Question: Summarize what this figure shows in one sentence.
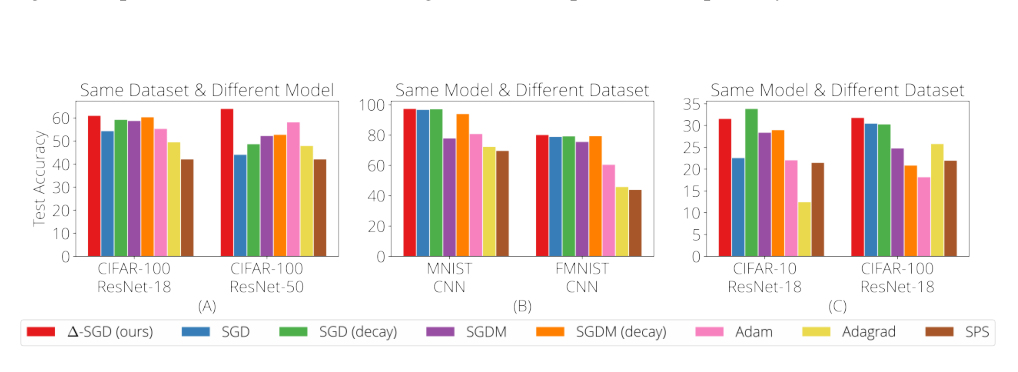
Answer: The effect of changing the dataset and the model architecture on different client optimizers. ∆-SGD remains superior performance without additional tuning when model or dataset changes, whereas other methods often degrades in performance. (A): CIFAR-100 trained with ResNet-18 versus Resnet-50 (α = 0.1), (B): MNIST versus FMNIST trained with CNN (α = 0.01), (C): CIFAR-10 versus CIFAR-100 trained with ResNet-18 (α = 0.01).